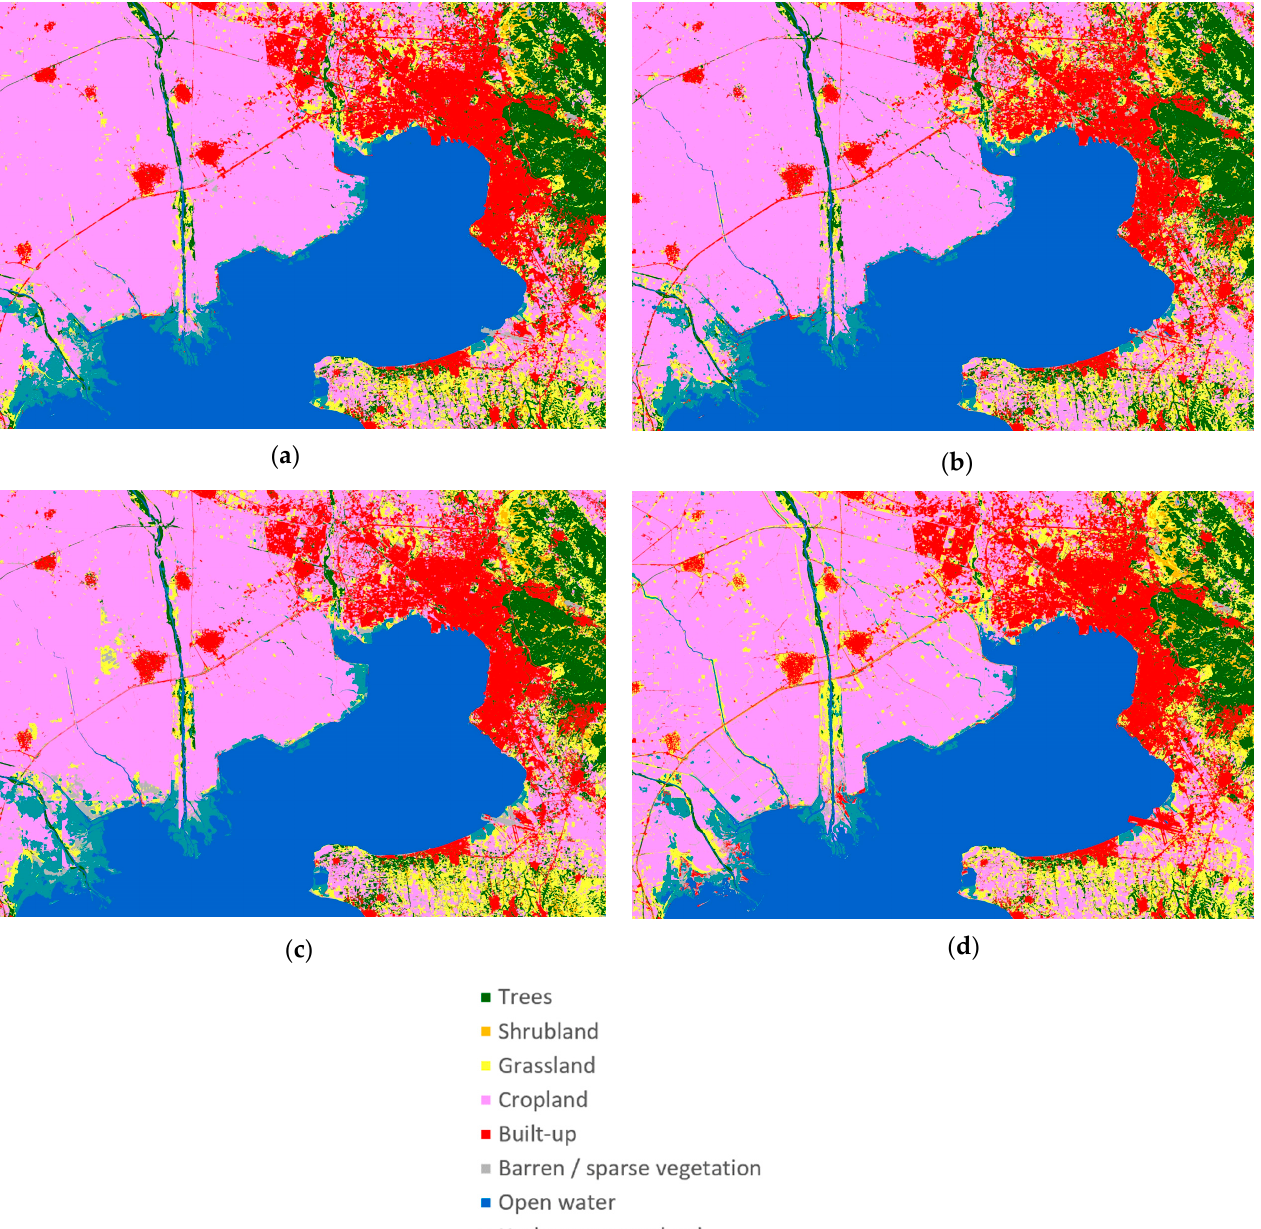
Figure 8. The predicted segmentation maps for each method. From left to right, top to bo tt om: ( a )